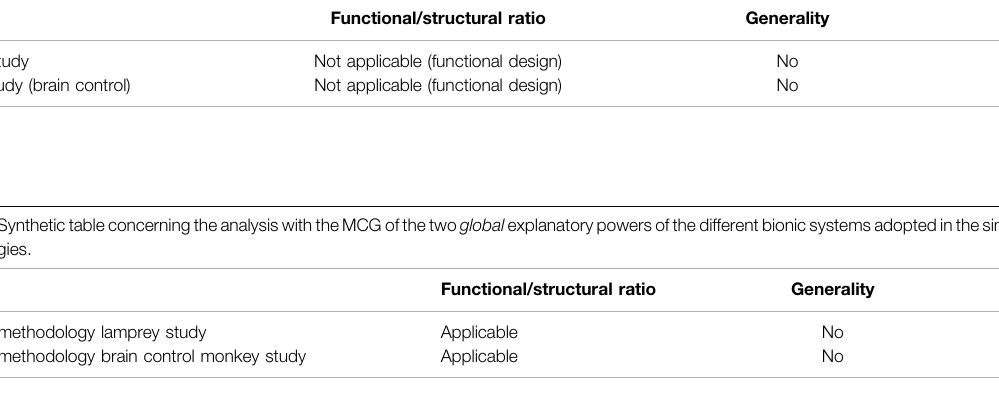
TABLE 2 | Synthetic table concerning the analysis with the MCG of the local explanatory power of the different bionic systems adopted in the simulation vs . stimulation methodologies. Functional/structural ratio